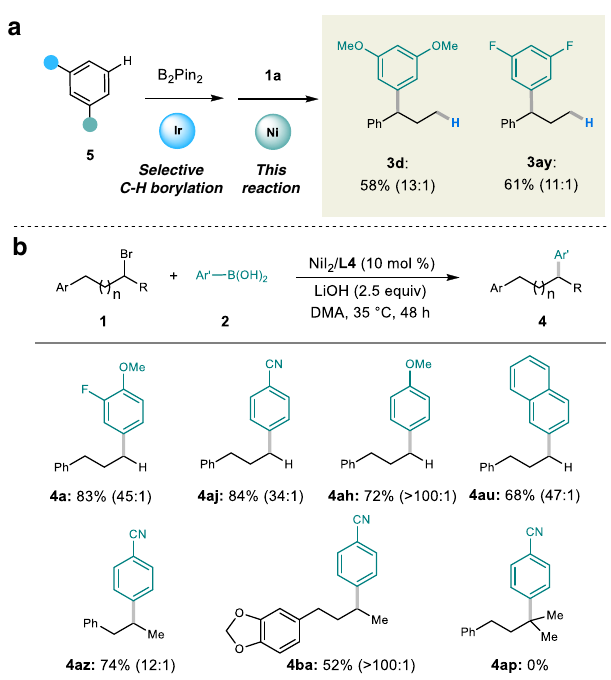
Fig. 3 Expansion of substrate scope. a Migratory Suzuki – Miyaura cross- coupling of aryl borate. b Original-site Suzuki – Miyaura